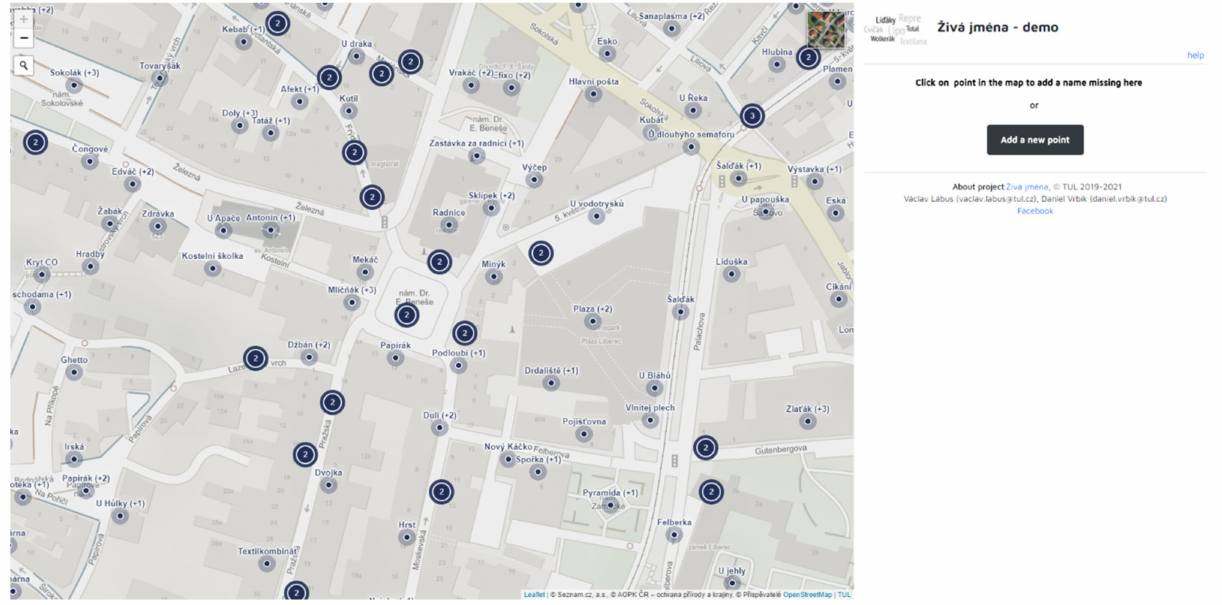
Figure 2. A view of the desktop version of the application. The application is developed in the Czech language. For the demo version, refer to https://mapy.fp.tul.cz/app/zj-demo/ (accessed on 5 May